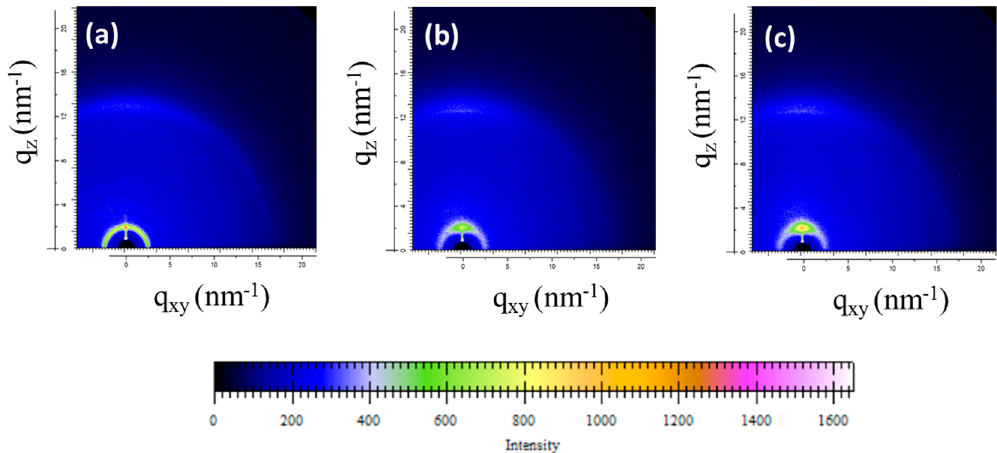
Figure 4. 2D-GIXRD images of thin films of ( a ) PTTVBDT; ( b ) PTTVBDT-TPD; ( c ) PTTVBDT-DPP which were prepared by drop-casting and then thermal annealing at 120 °C, 20 min.